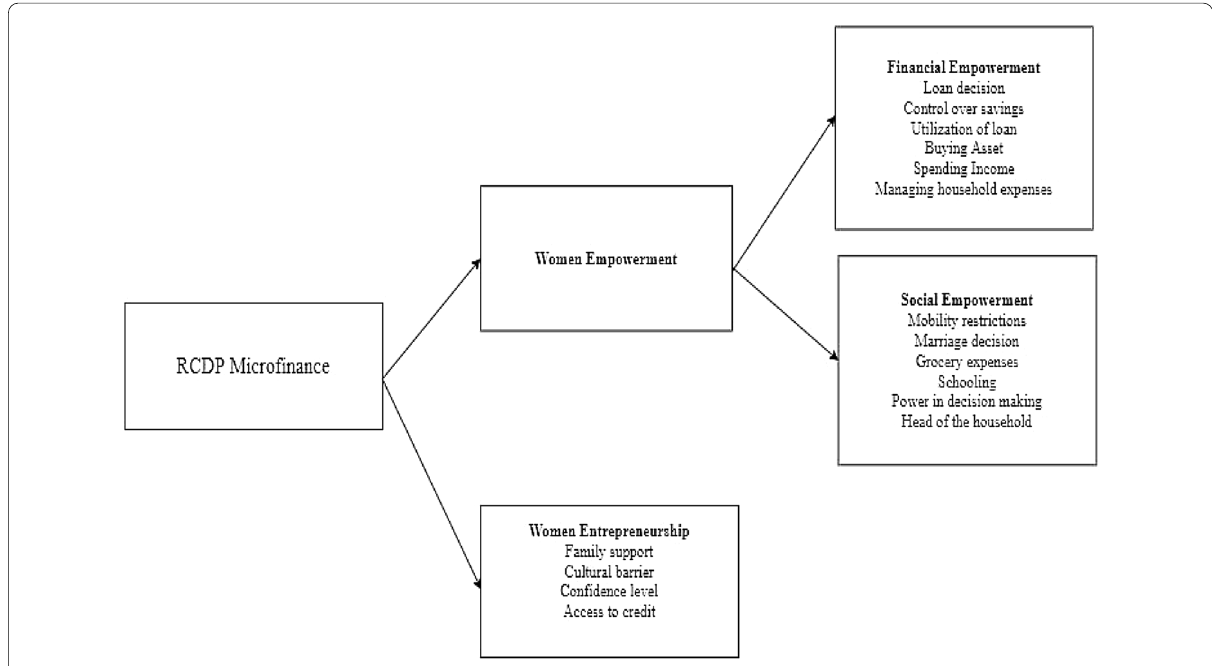
Fig. 1 Conceptual framework of the study